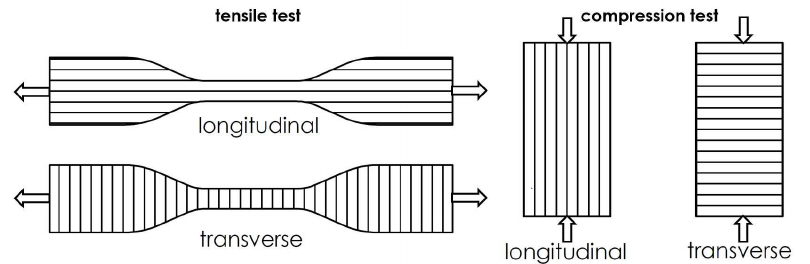
Figure 1. Left : Direction of printing for the Type IV specimen according to Standard ASTM D638-14, Right : Direction of printing for the compression test specimen according to Standard ASTM D695-15.